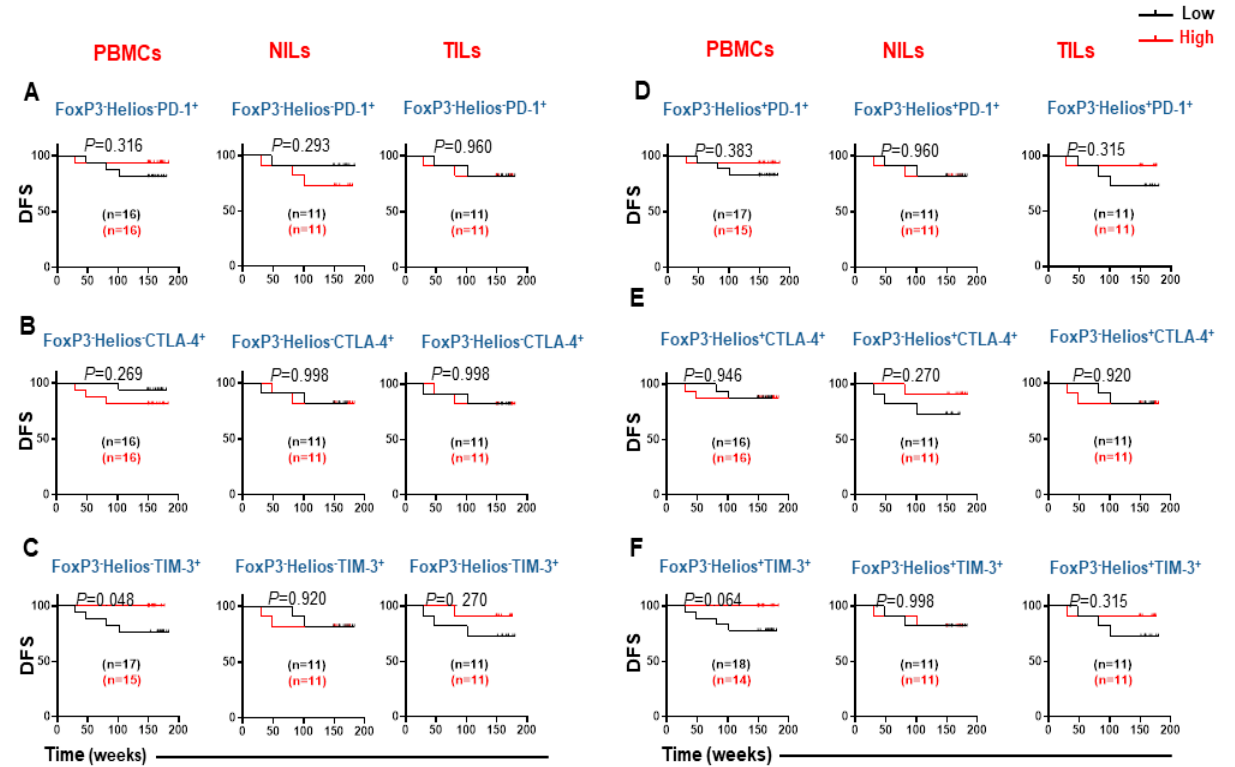
Figure 5. Kaplan–Meier survival curves for DFS based on the levels of FoxP3 − Helios − and FoxP3 − He- lios + CD3 + CD4 − T cells expressing PD-1, CTLA-4, and TIM-3. CRC patients with high levels of FoxP3 − Helios − PD-1 + ( A ), CTLA-4 + ( B ), TIM-3 + ( C ), and FoxP3 − Helios + PD-1 + ( D ), CTLA-4 + ( E ), and TIM-3 + ( F ) cells were compared with CRC patients with low levels of these cells to determine DFS. The number of patients included in each comparison are specified on each survival curve.